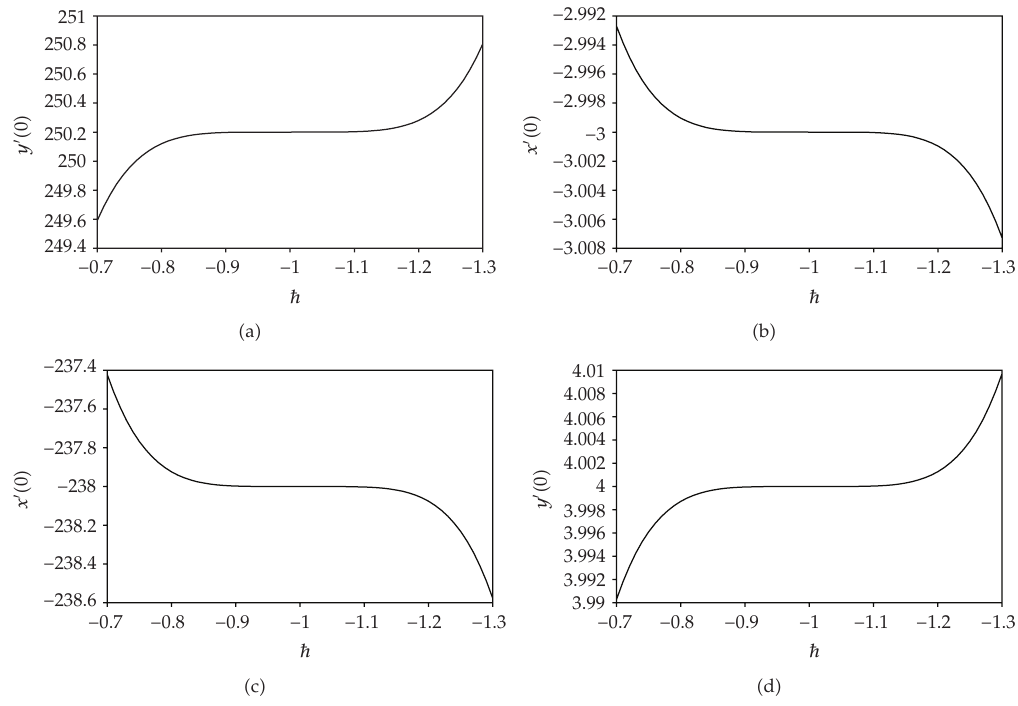
Figure 1: The (cid:2) -curves for 5th-order of approximations. (cid:3) a (cid:4) and (cid:3) b (cid:4) The curves of x for Cases 1 and 5. (cid:3) c (cid:4) and (cid:3) d (cid:4) The curves of y for Cases 1 and